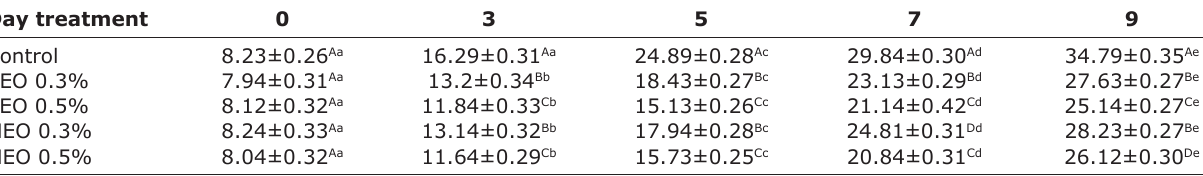
Table-3: TVBN values of minced beef containing different levels of ZEOs and MEOs during 9 days of storage at 7°C. Day treatment